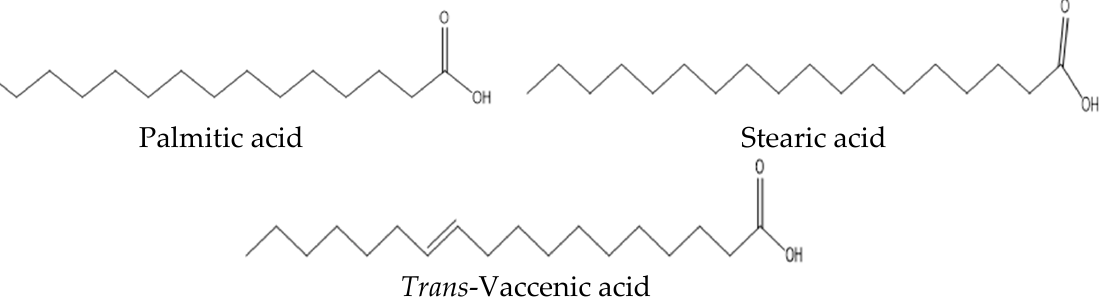
Figure 3. Chemical structures of the fatty acids found in Terfezia claveryi . Scopoletin was detected at m/z (191.0347), with a major fragment at m/z (44.9722), indicating a loss of (COOH). In addition, 3, 5-dimethoxy-4-hydroxy acetophenone was detected at m/z 195.0669. Isoferulic acid was detected at m/z (193.051), with a major fragment at m/z (44.9988), representing COOH. Carbohydrates are the main macronutrients present in truffles. In all the analyzed truffle extracts, piscopyranose, mannitol and trehalose peaks were detected between 0.59 and 1.26 min.